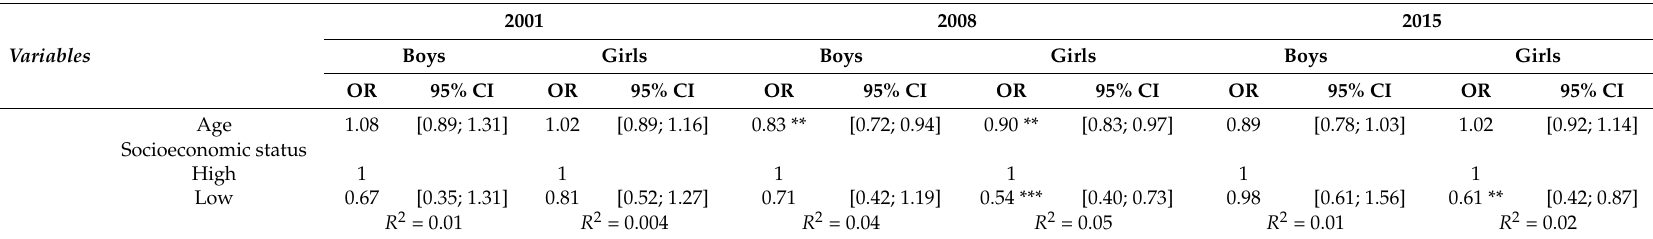
Table 2. Odds ratio (OR) and 95% confidence interval (CI) describing the relationship between sport participation and socioeconomic status by sex and year, adjusted for